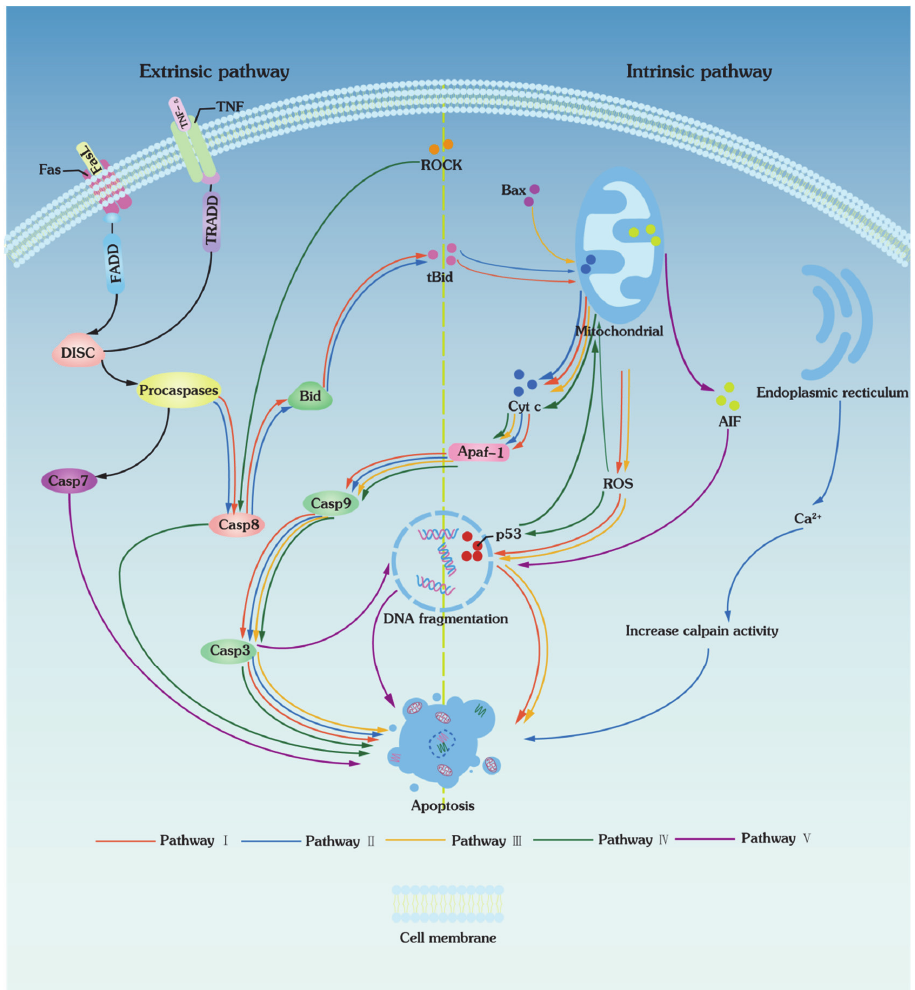
Figure 2. Proposed hypothetical model of cryopreservation-induced apoptosis via caspases. Path- ways I and II are extrinsic pathways that stimulate the intrinsic pathways, while pathways III, IV, and V are intrinsic pathway that stimulate the extrinsic pathways. Cryopreservation causing cells apoptosis includes extrinsic and intrinsic pathways; there are five apoptotic pathways summarized based on the previous studies. In the extrinsic pathways, ROCK and procaspases are activated, which induce the caspase cascade reaction. In the intrinsic pathways, the release of Bax, tBid, and ROS induces the mitochondrial permeability transition pore to be opened, resulting in a caspase cascade reaction or DNA fragmentation to trigger apoptosis.